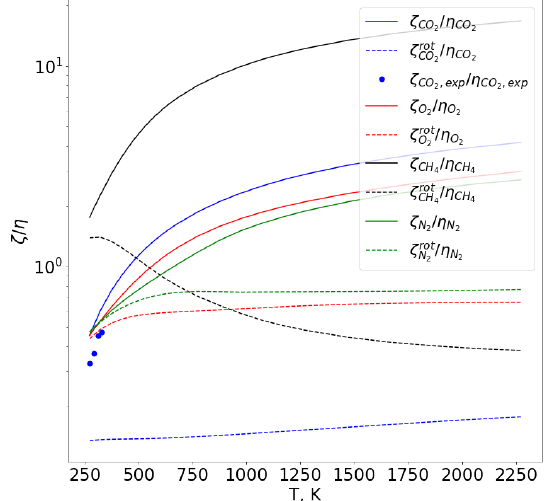
Figure 3. Ratio of bulk and shear viscosity coefficients for different gases. Solid lines: ζ / η , dashed lines: ζ rot / η